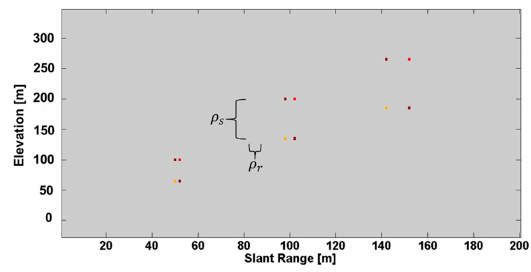
Figure 6. Original signal in the range-elevation plane.